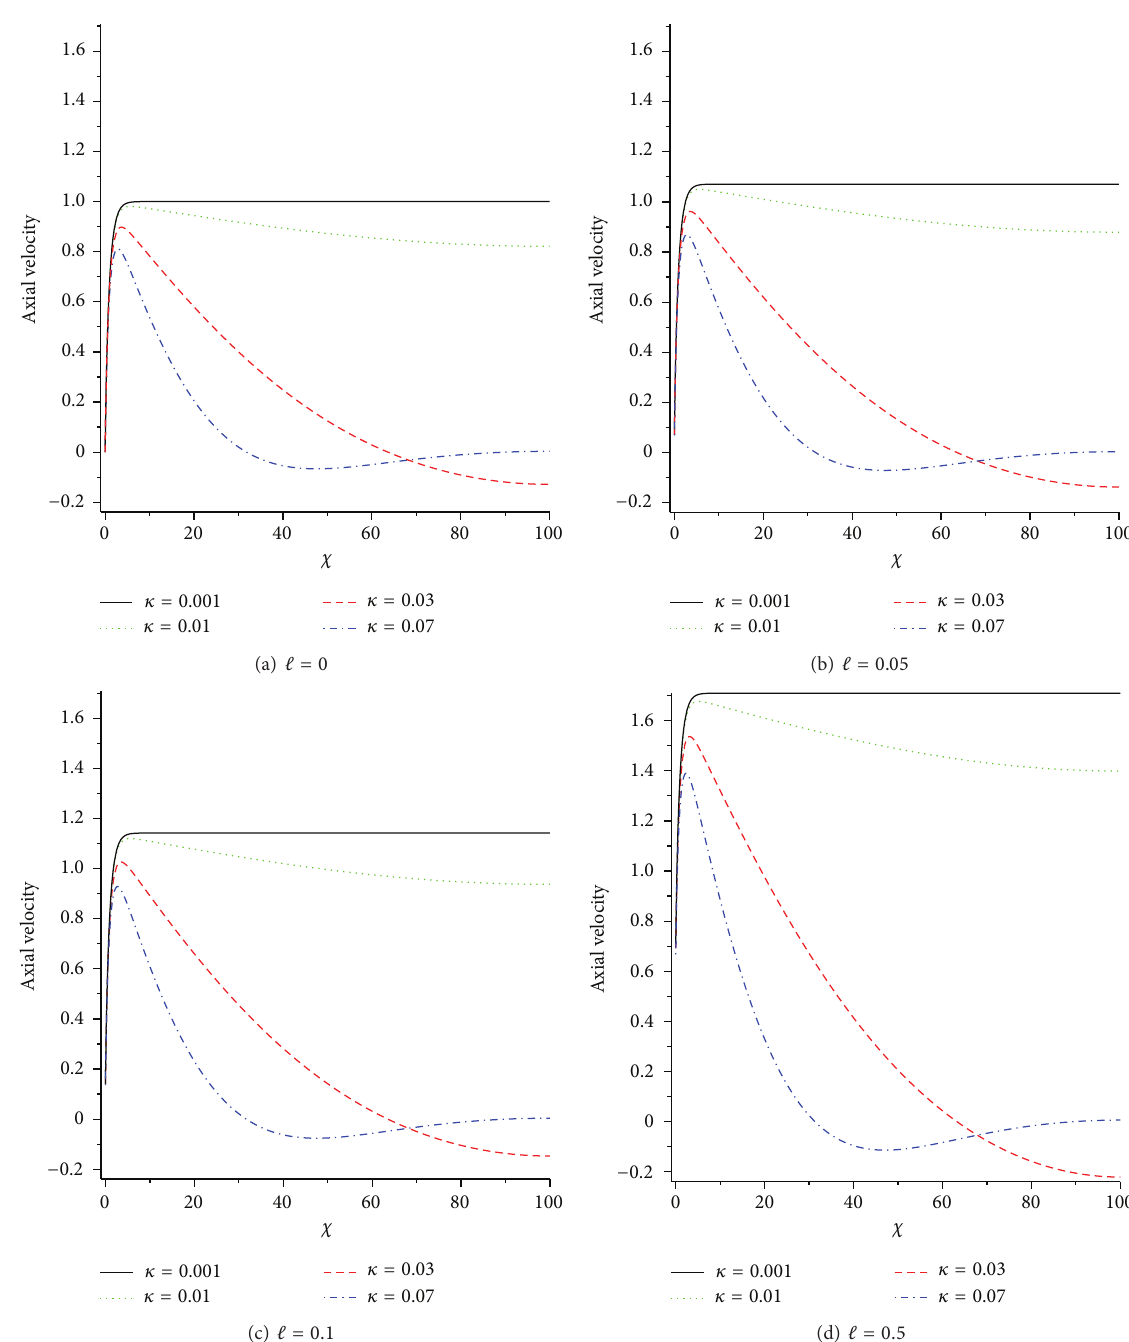
Figure 3: Effect of 𝜅 on velocity profile obtained from the model with 𝜃 = 𝜋/2 , 𝛼 = 1 , and ℎ = 100 𝜆 for various slip lengths: (a) ℓ = 0 ; (b) ℓ = 0.05 ; (c) ℓ = 0.1 ; (d) ℓ = 0.5